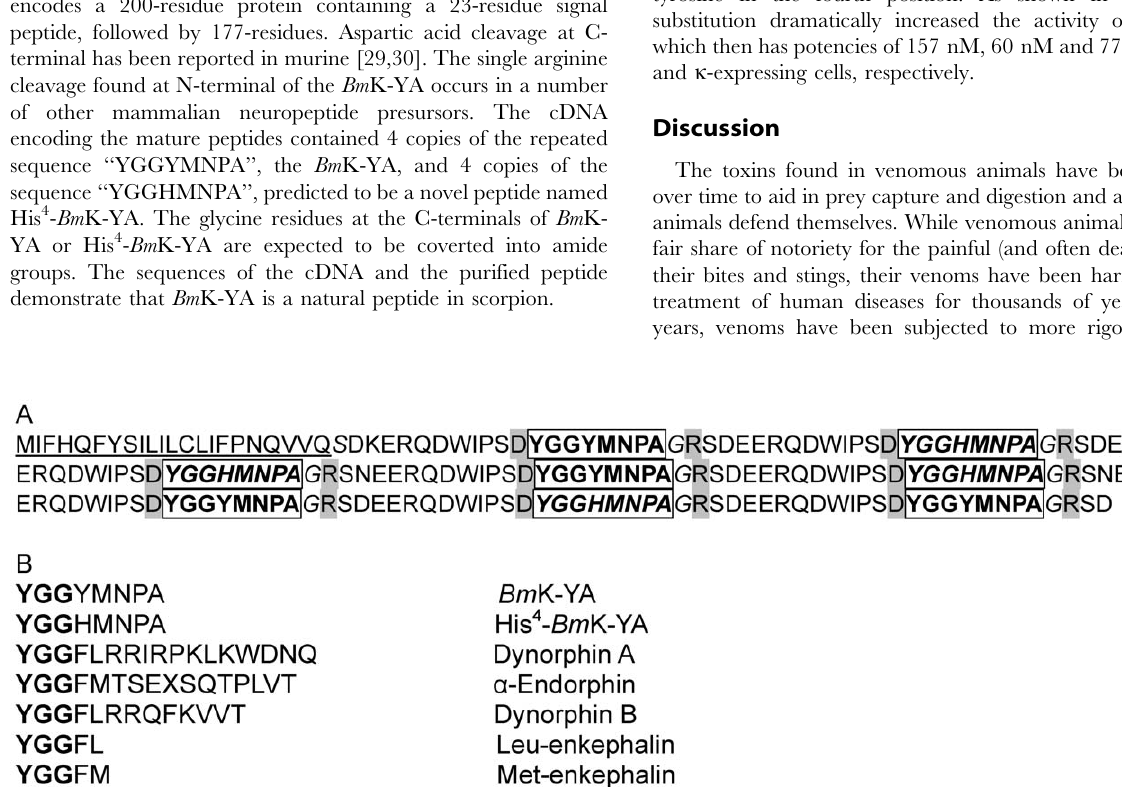
Figure 2. Purification of Bm K-YA from Fraction 17. (A) Chromatographic profile of F17 separated by Click Maltose column using HILIC mode. The mobile phase was composed of water (A), ACN (B) and 100 mM TEAP buffer (pH 2.3) (C). The gradient was from 10% A to 45% A over 40 min, then from 45% A to 50% A over 20 min under a constant 5% C. (B) RPLC analysis and comparison of the purified natural Bm K-YA and the synthetic one. The mobile phase B (ACN with 0.1%TFA) was from 5% to 35% in 25 min on a Xterra MS C18 column at a flow rate of 0.2 mL/min. Absorbance was measured at 220 nm. (C) Q-TOF mass spectra of the natural Bm K-YA with a [M + H] + monoisotopic mass of 871.3088. (D) Single charged and deconvoluted (MaxEnt3 processed spectra) CID spectra and amino acid sequence of Bm K-YA.